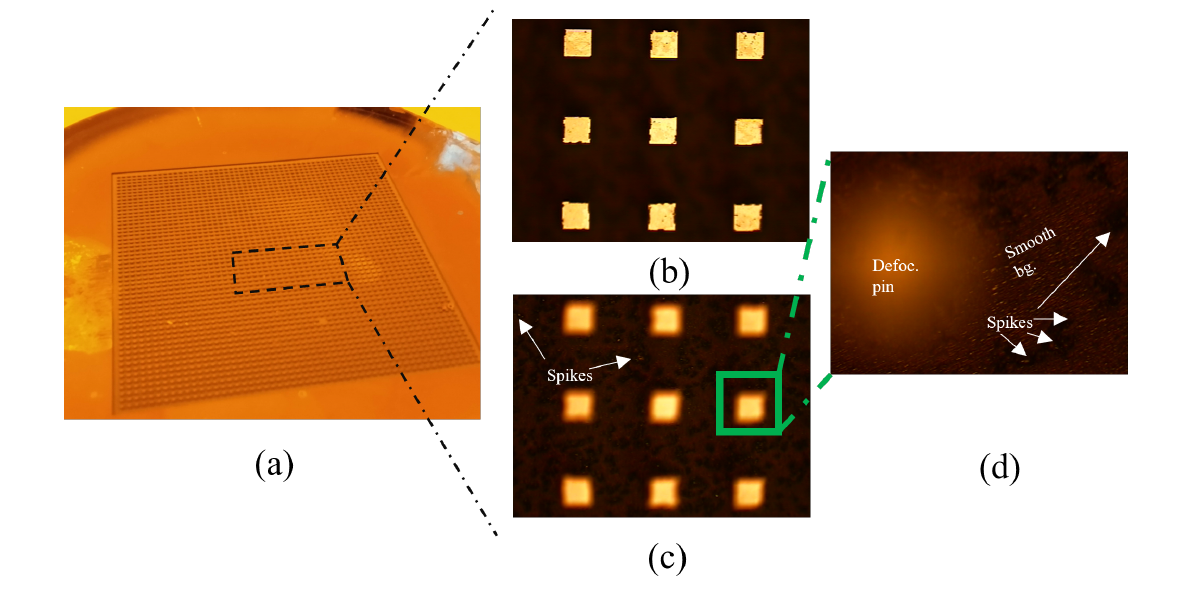
Figure 14. Bed of pins manufactured by DRIE Bosch process and coated with copper and gold by sputtering process. ( a ) Overview. ( b ) Front view with optical focus on pin layout. ( c ) Front view with optical focus on background (bg) surface. ( d ) Zoomed view of background surface.